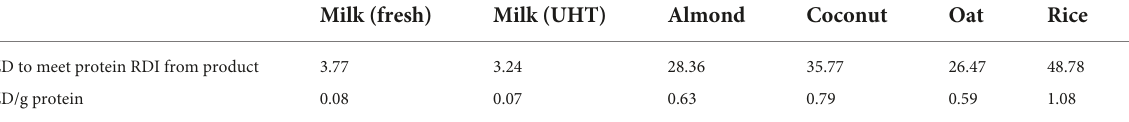
TABLE 3 Analysis of protein price for each product group. Milk (fresh) Milk (UHT) Almond Coconut Oat Rice Soy NZD to meet protein RDI from product